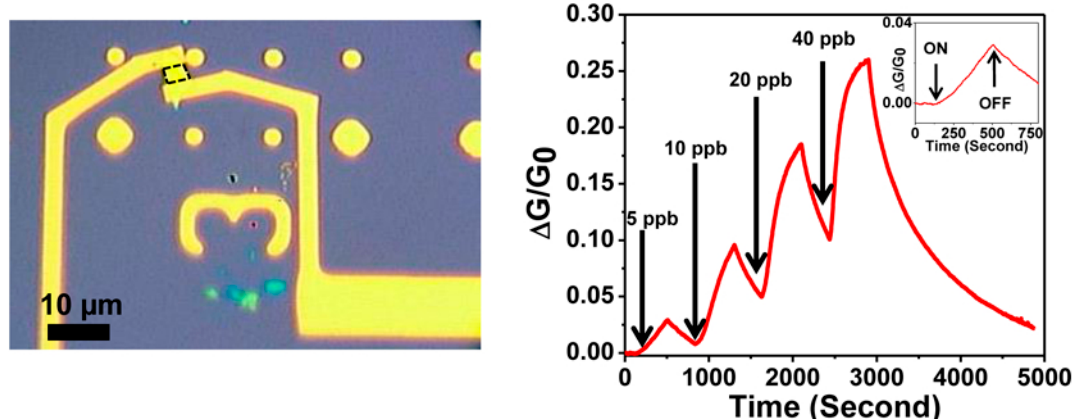
Figure 21. ( Left panel ) optical image of the phosphorene-based FET. The phosphorene flake is bounded by a dotted black line; ( Right panel ) conductance change of the phosphorene flakes exposed to different NO 2 concentrations. (Reproduced with permission from [204]. Copyright 2015 American Chemical Society, Washington, DC, USA).